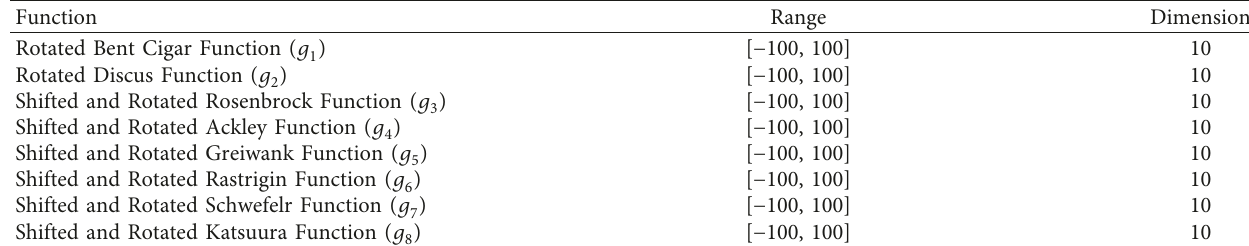
Table 2: Set of functions for F-Race-based SCEO tuning.